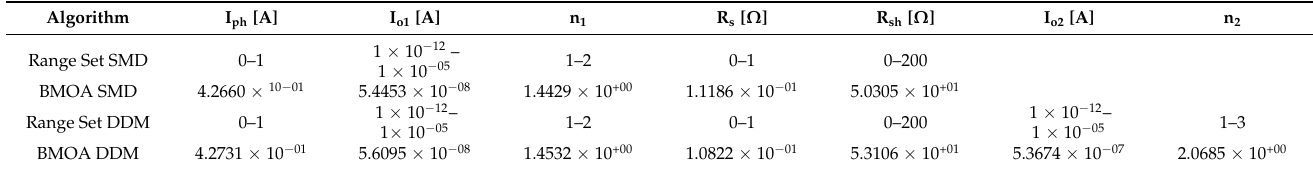
Table 3. Monocrystalline silicon photovoltaic cell parameters and range.